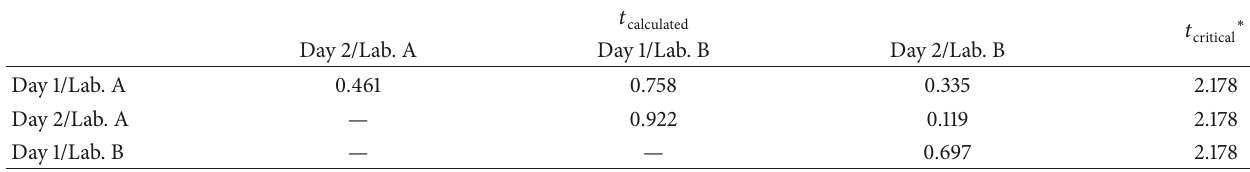
Table 5: Student’s t -test to the mean data in the evaluation of the